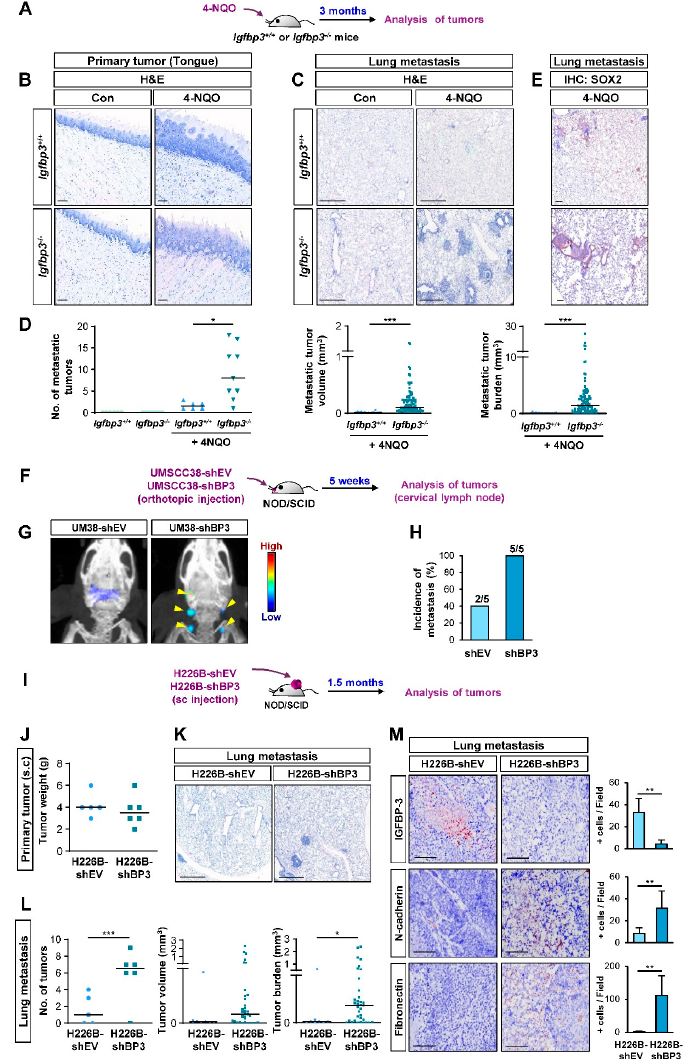
Figure 2. IGFBP-3 suppresses metastasis in vivo. ( A ) Schematic diagram illustrating the protocol to assess the impact of IGFBP-3 expression in metastasis of mouse HNSCC using the 4-NQO-induced HNSCC tumorigenesis model ( Igfbp3 +/+ Con: n = 6; Igfbp3 +/+ 4-NQO: n = 7; Igfbp3 − / − Con: n = 6; Igfbp3 − / − 4-NQO: n = 9). ( B , C ) Primary ( B ) and metastatic ( C ) tumor formation in 4-NQO-administered mice was determined by H&E staining of the tongue ( B ) and lung ( C ) tissues. Scale bars: 25 µ m ( B ), 1 mm ( C ). ( D ) Microscopic evaluation of the metastatic tumors in the lungs. ( E ) IHC analysis to determine the level of SOX2 expression in lung tissues. Scale bars: 25 µ m. ( F ) Schematic diagram illustrating the protocol to assess the impact of IGFBP-3 expression in metastasis of human HNSCC using orthotopic tongue xenograft tumor model ( n = 5 per group). ( G ) Representative IVIS images showing metastatic tumor formation in mice bearing UMSCC38-shBP3 tumor xenografts. ( H ) Microscopic evaluation showing increased metastasis in cervical lymph nodes in mice bearing UMSCC38-shBP3 cells compared with those in UMSCC38-shEV cells. Three cervical lymph nodes per mouse were evaluated. ( I ) Schematic diagram illustrating the protocol to assess the impact of IGFBP-3 expression in metastasis of human NSCLC using NSCLC xenograft tumor model (shEV: n = 5; shBP3: n = 6). ( J ) Changes in the weight of primary tumors between H226B-shEV and H226B-shBP3 tumor xenografts. ( K , L ) Upregulated metastatic tumor formation in mice bearing H226B-shBP3 tumor xenografts compared with those bearing 226B-shEV tumor xenografts, as determined by H&E staining of lung tissue sections ( K ) and microscopic evaluation of H&E-stained tissues ( L ). ( M ) The level of tumoral expression of N-cadherin and fibronectin in H226B-shEV and H226B-shBP3 xenograft tumors was determined by IHC analysis. Scale bars: 1 mm ( K ), 0.5 mm ( M ). The bar represents mean ± SD. * p < 0.05, ** p < 0.01, and *** p < 0.001, as determined by Mann-Whitney test ( D , L (middle and right), M ) and the two-tailed Student’s t -test ( L , left) compared with the corresponding control. EV: empty vector; BP3: